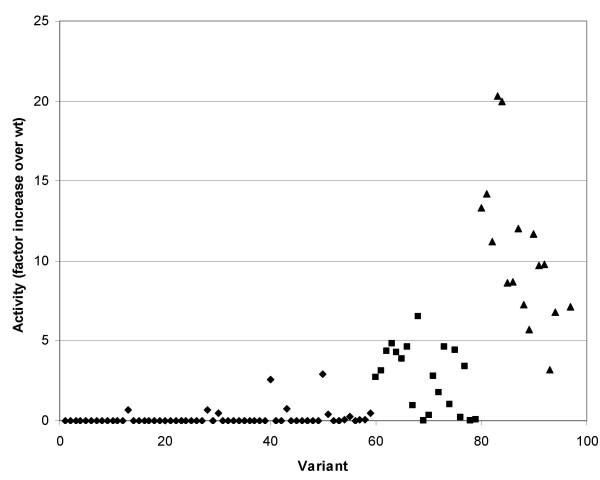
Three cycles of proteinase K variant design and testing. Mean activity measurements of the 3 sets of proteinase K variants are shown. Set 1 (diamonds) is the initial set of 59 variants. Set 2 (squares, 20 variants) was designed using the activities of Set 1. Set 3 (triangles, 16 variants) was designed based on sets 1 and 2. Activities towards N-Succinyl-Ala-Ala-Pro-Leu p-nitroanilide were measured at 37°C following a 5 minutes heat treatment of the enzyme at 68°C. Activities are expressed relative to the mean activity of 2 replicates of the wild-type proteinase K.